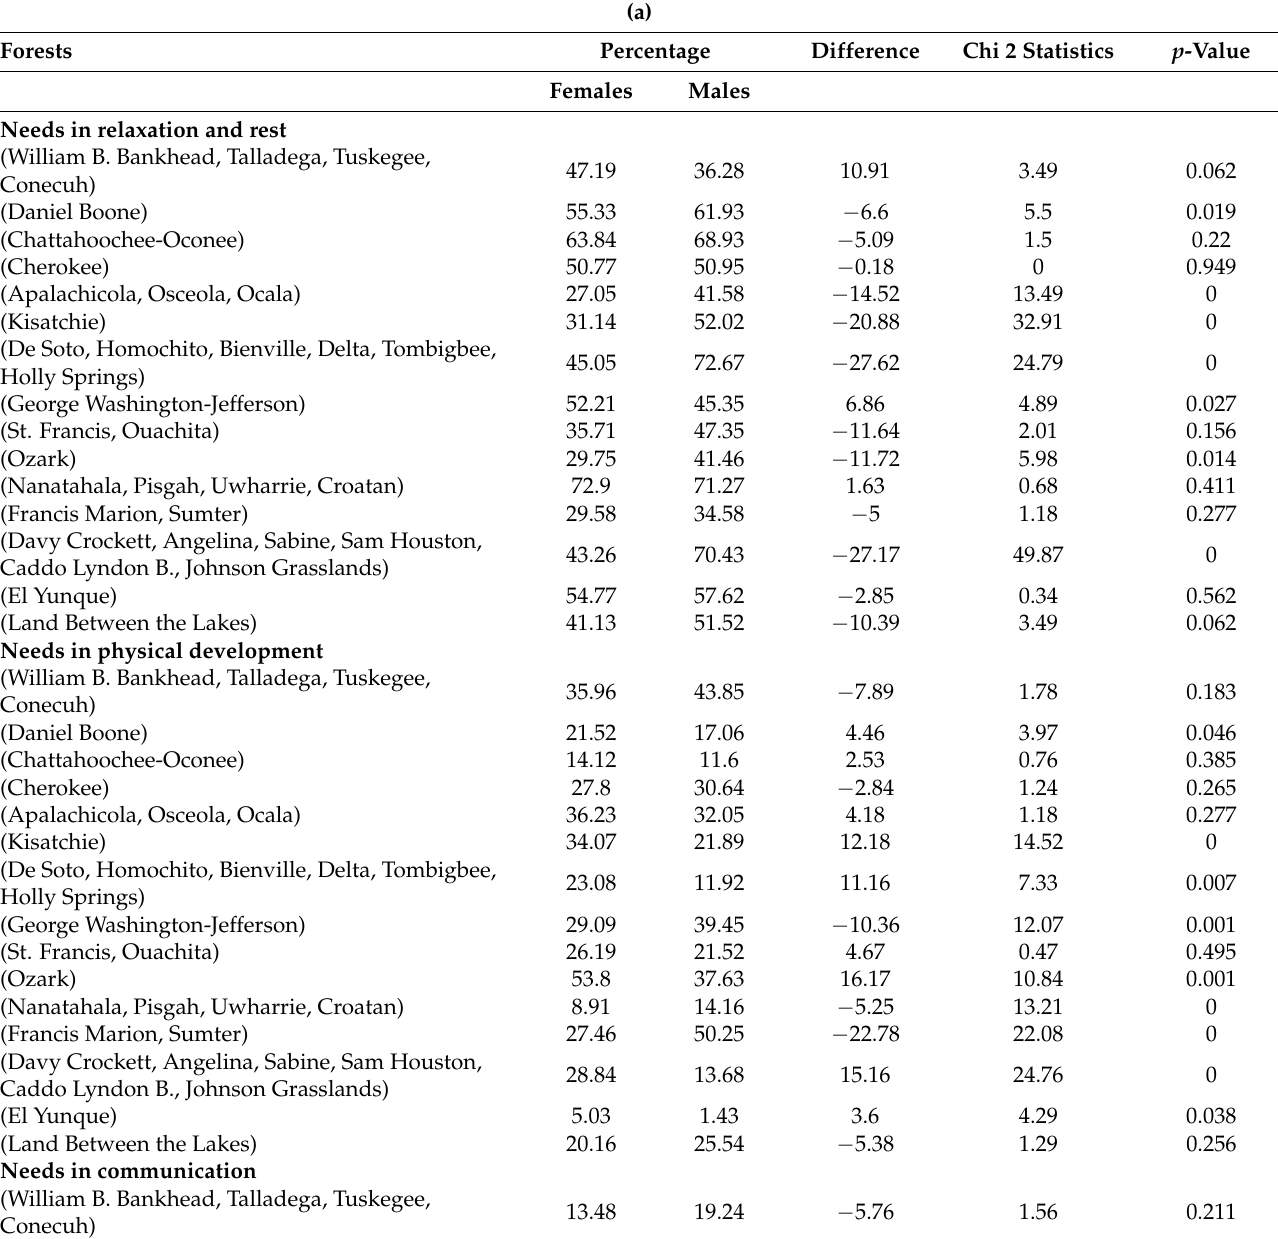
Table 6. ( a )The results of the Chi-squared test for between-group (gender) comparisons across forests. ( b ) The results of the Chi-squared test for between-group (ethnicity) comparisons across forests. (a)